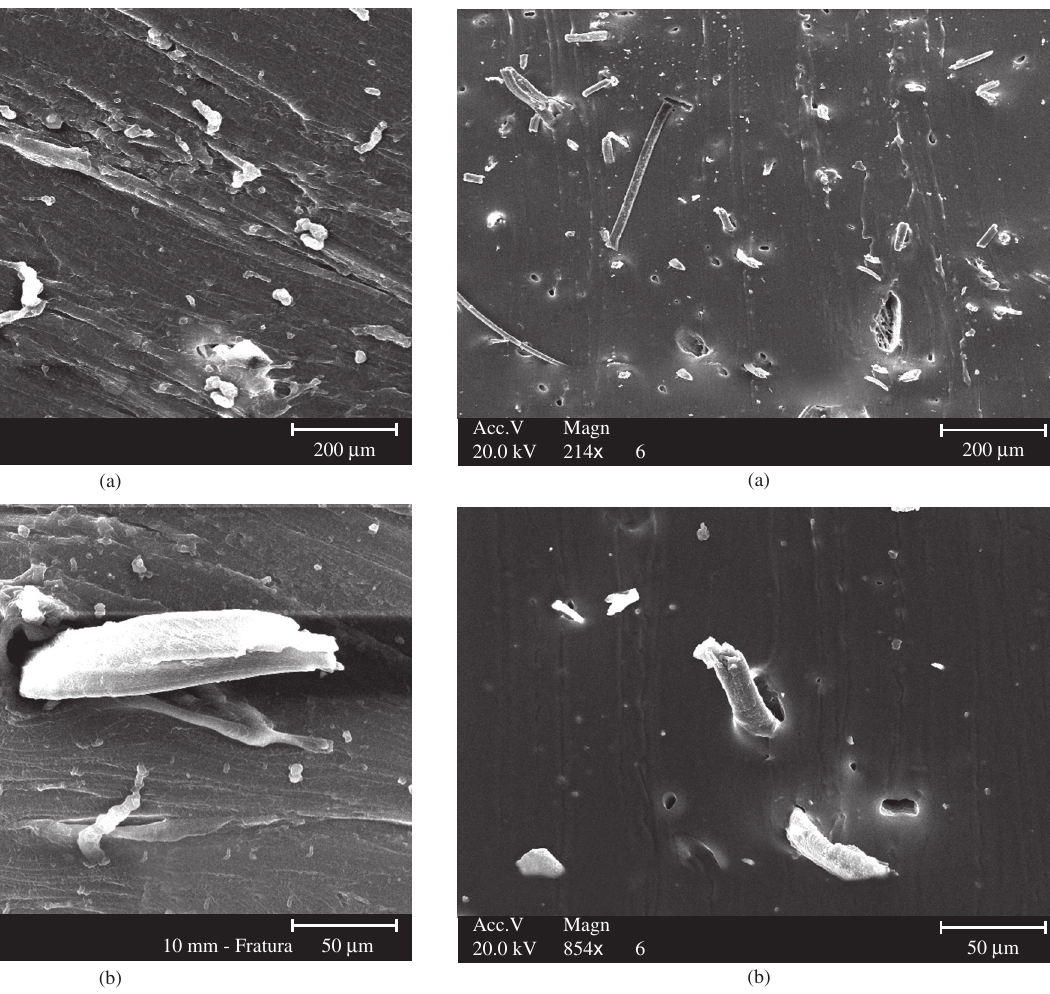
Figure 2. Scanning electronic micrographs of SBS/5% short sisal fiber composites processed in a single-screw extruder: a) short magnification and b) higher magnification – fiber detail.